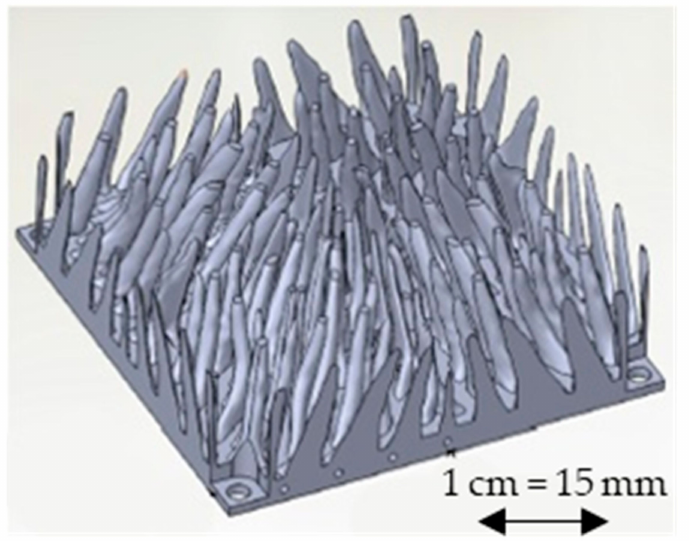
Figure 1. Topology-optimised AM-fabricated Pin-Fin HX CAD model. Reprinted with permission from [7]. Copyright 2015 by American Society of Mechanical Engineers